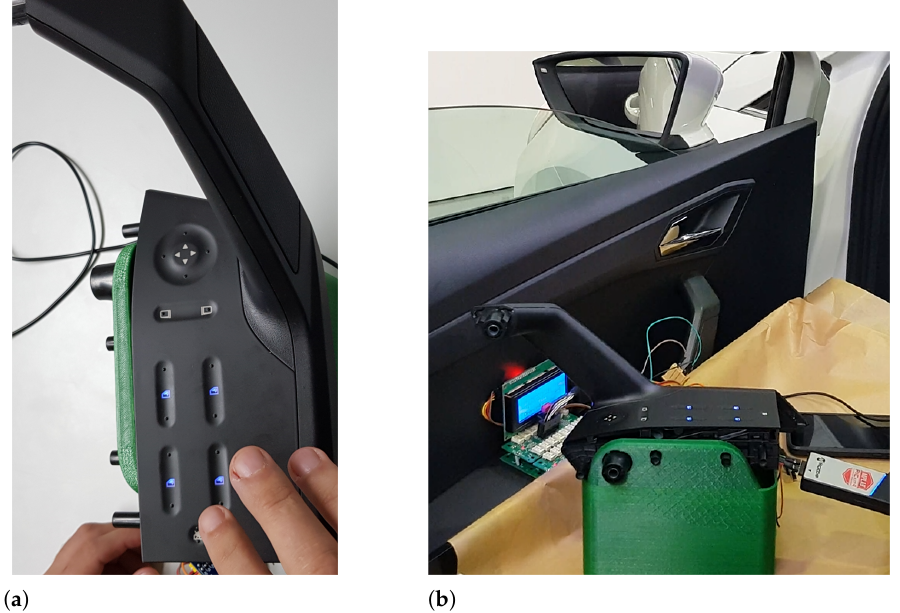
Figure 20. The functional prototype connected to the door of a real automobile manufactured in 2018. ( a ) depicts the new single-component touch-based polymer panel in detail, while ( b ) shows the panel that was integrated in the vehicle’s door, controlling the four windows (front left and right, and rear left and right) and the two rear-view